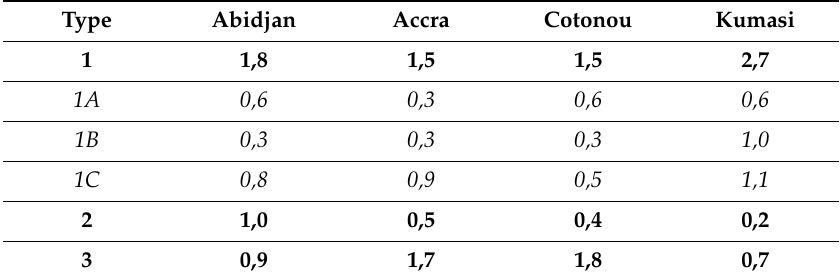
Table 2. Mean annual number of days for the di ff erent types of events at major towns of southern West Africa (the total number is 3.6 events per year for each location). Abidjan, Accra and Cotonou are coastal towns while Kumasi is located inland. Type Abidjan Accra Cotonou